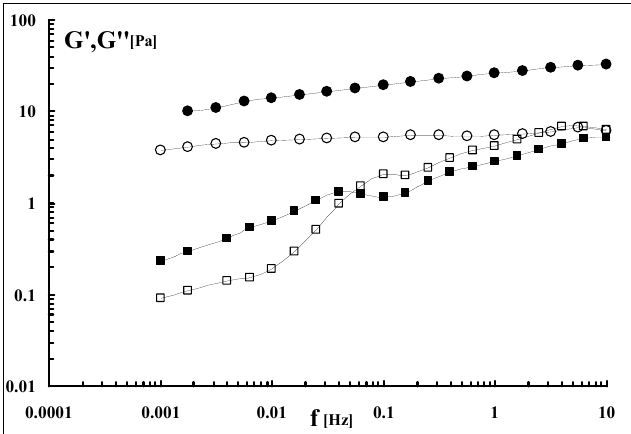
Figure 5. Mechanical spectra of dialysed Sclg ( ● , ○ ) and of Sclg sonicated for 5 min ( ■ , □ ); cp = 0.7%, T = 25 °C (G’ = full symbols; G” = empty